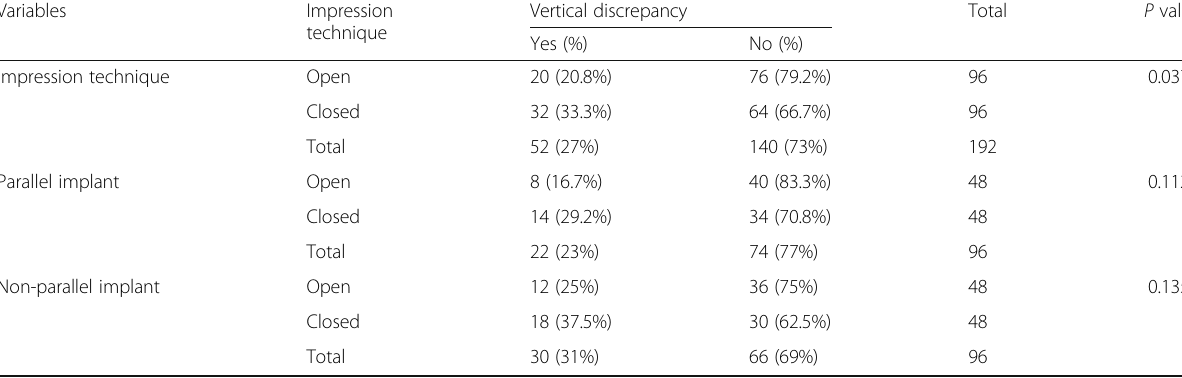
Table 4 Vertical discrepancy and impression technique accuracy